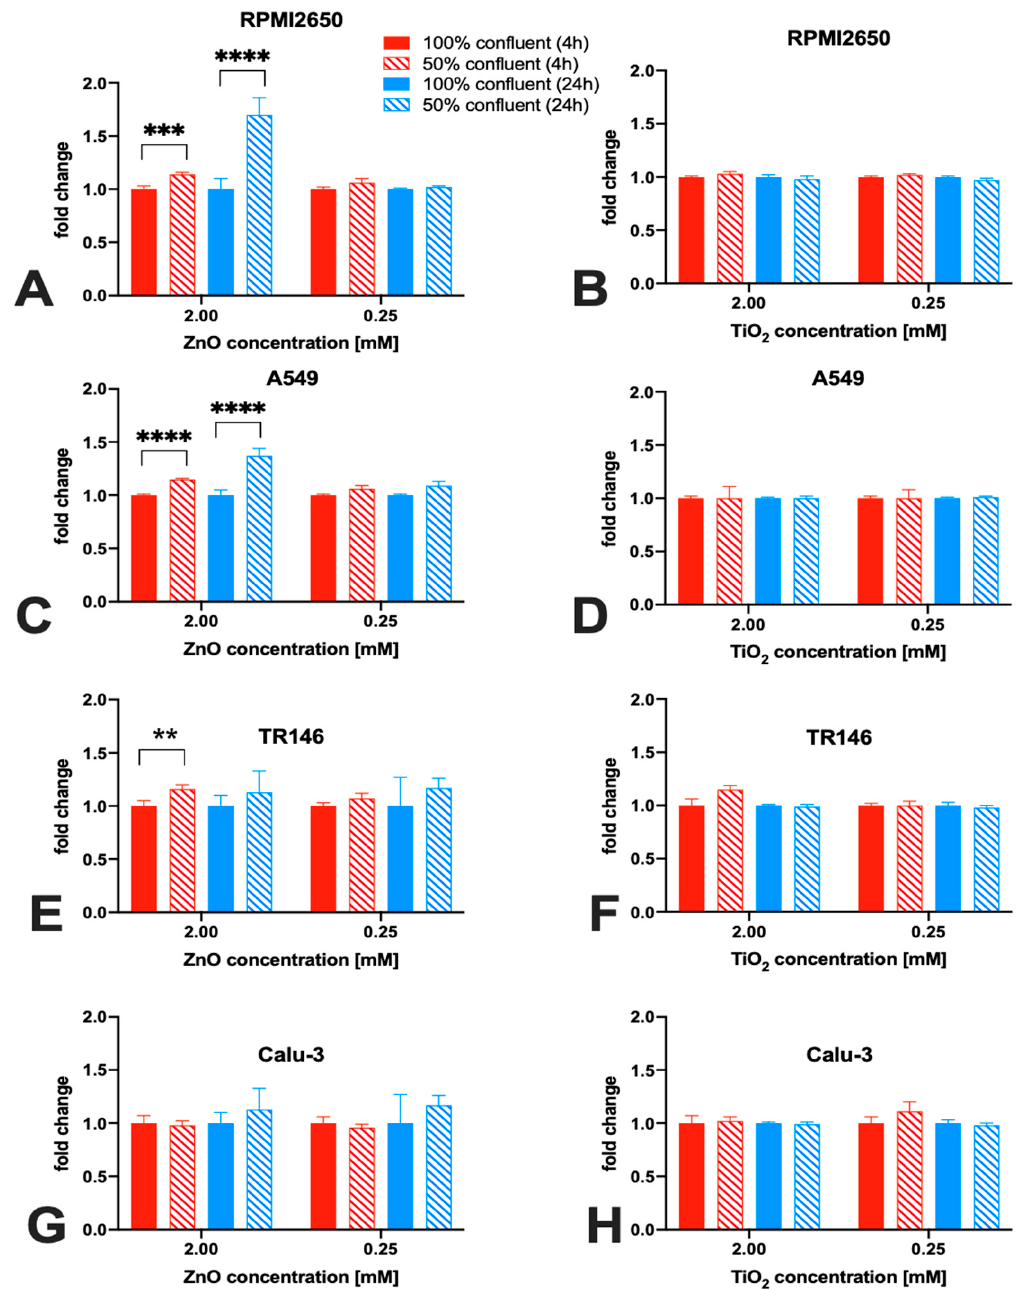
Figure 6. The impact of cell confluency on nanoparticle cytotoxicity of four mucosal cell lines including ( A , B ) RPMI2650, ( C , D ) A549, ( D , E ) TR146, and ( F , G ) Calu-3. Cell viability was measured using a Presto Blue assay at 4 and 24 h post-exposure to 80 nm sized, uncoated ZnO NPs ( A , C , E , G ) as well as 5 nm sized, uncoated TiO 2 NPs ( B , D , F , H ). Data are expressed as mean ± standard deviation for n = 3 replicates. Two-way ANOVA corrected with a Tukey test: ** p < 0.02, *** p < 0.0002, **** p < 0.0001.